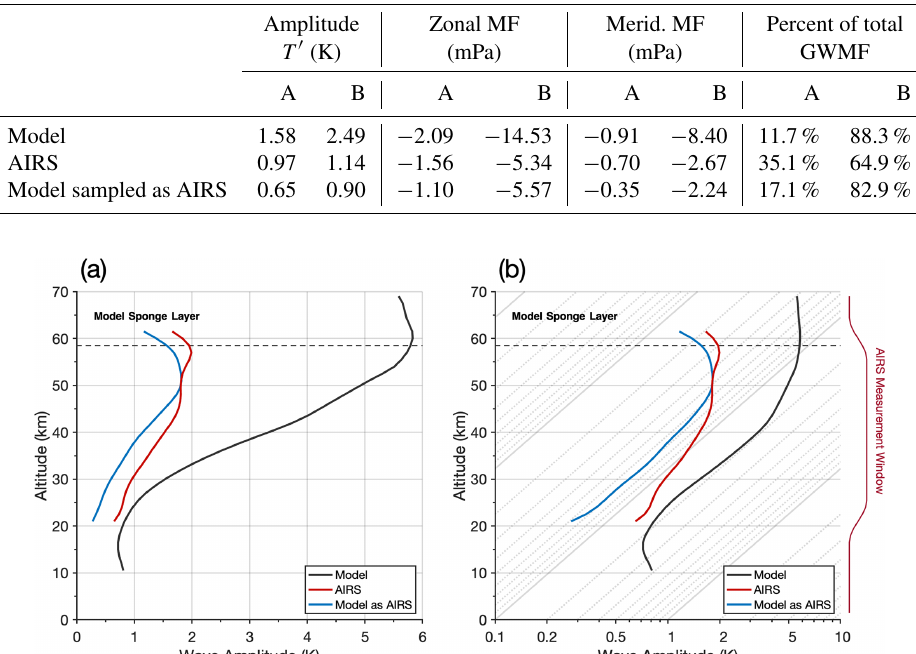
z 2 H expected from theory for an